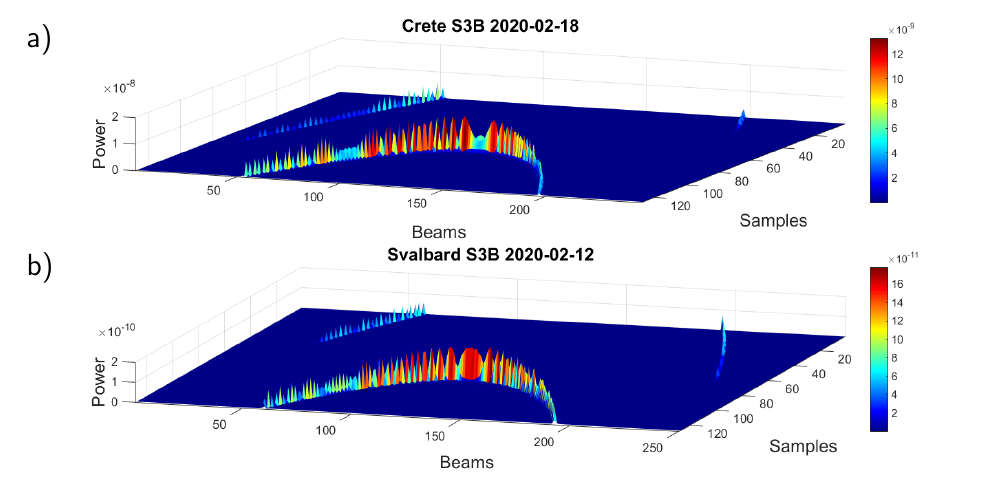
Figure 20. Stack data for ( a ) Sentinel 3B pass (2020-02-18) over Crete and ( b ) Sentinel 3B pass (12 February 2020) over Svalbard.